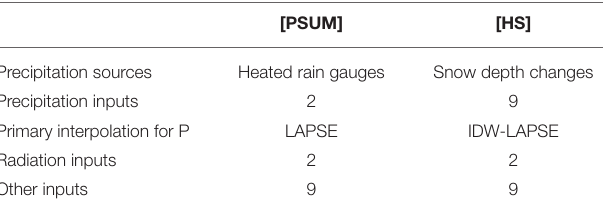
TABLE 1 | Overview of the inputs and interpolation methods used in the